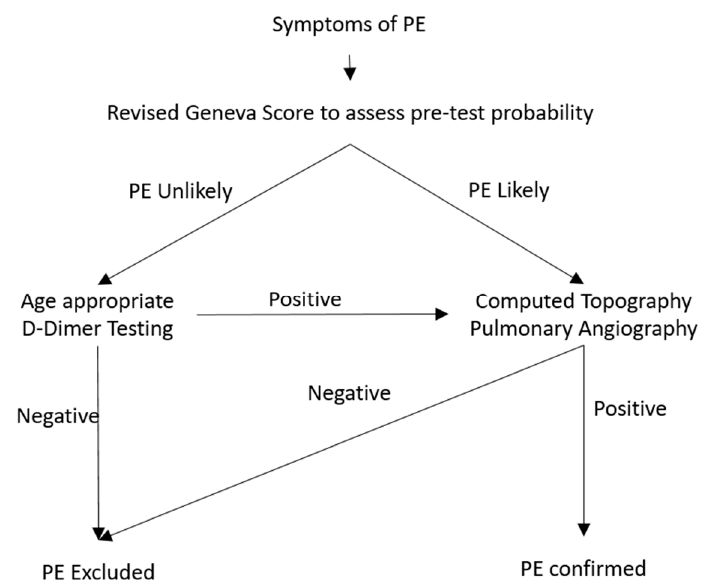
Figure 1. Diagnostic algorithm for suspected pulmonary embolism in a non-pregnant patient.